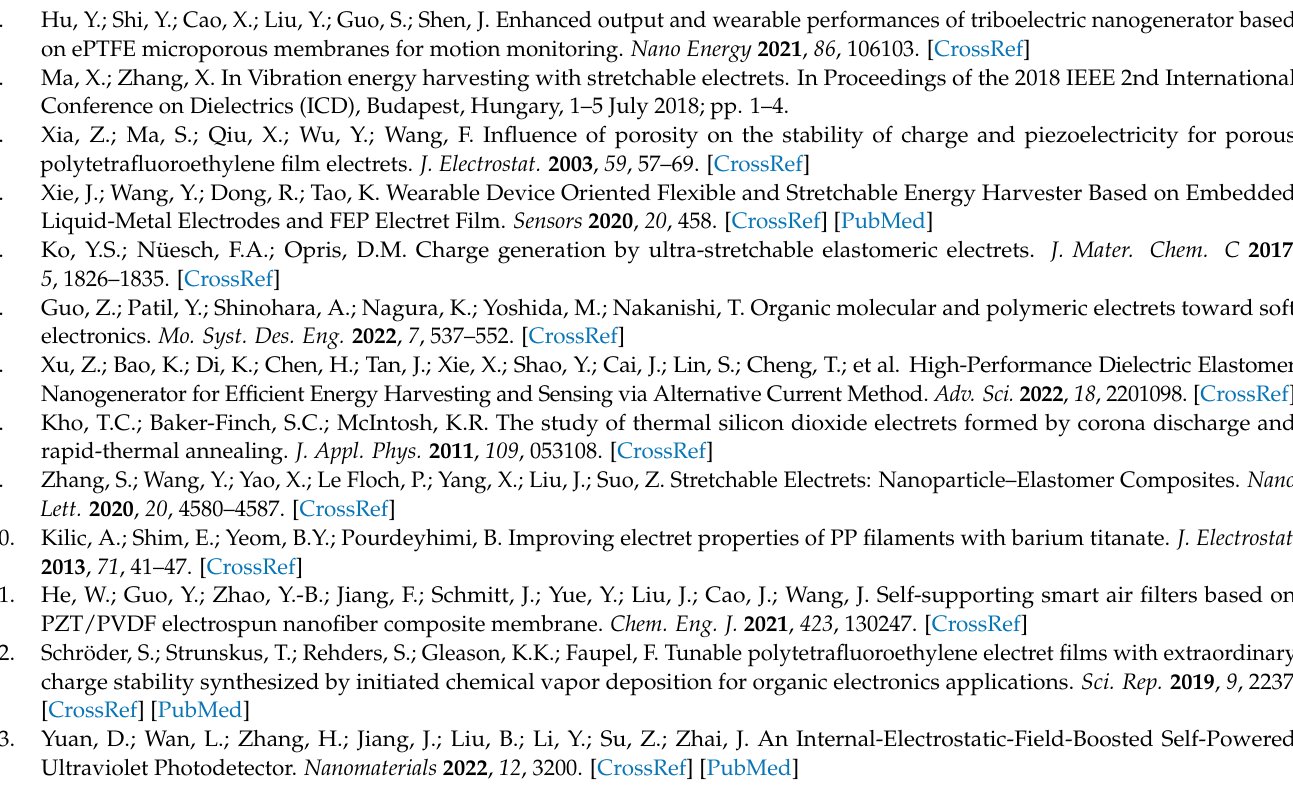
ePTFE membrane and (b) Ecoflex film. Figure S2. SEM image of the pristine ePTFE membrane. Figure S3. Contact angles of water (a) and Ecoflex oilgomer (b) on the surface of ePTFE membrane. Figure S4. Photos displaying superior flexibility of the electret composite under different deformation (a) rolling up, (b) folding, (c) twisting and (d) crumpling. Figure S5. Stress-strain curves of the ePTFE film (a) and Ecoflex (b) under uniaxial tensile test. (c) Comparison of the tensile strain and stress of the ePTFE, Ecoflex and electret composite. Stress-strain curves of the ePTFE film (d) and Ecoflex (e) under cyclic tensile test (200% strain). Figure S6. The variation of output current (a) and voltage (b) of Ecoflex and electret composite under periodic tensile test. Figure S7. (a) The water contact angle of the as-fabricated sensor. (b) The photo of the sensor soaked in the water. (c) The peak current and ∆ Q of the sensor as a function of soak time. Figure S8. (a) Basic structure diagram of stretchable electret. (b) Basic physical model of stretchable